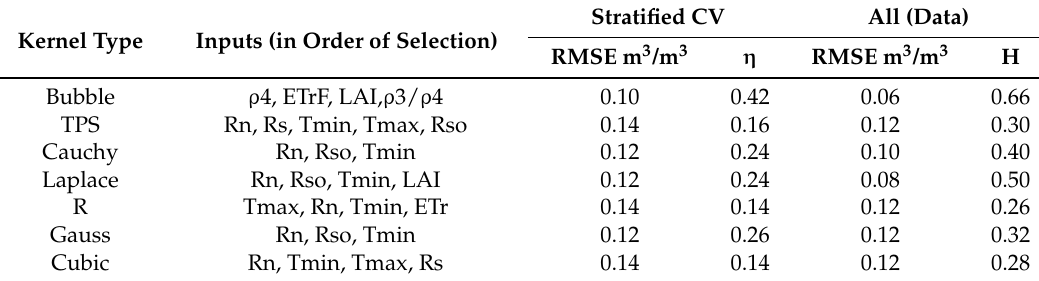
Table 7. RVM statistics for best soil moisture models using each kernel